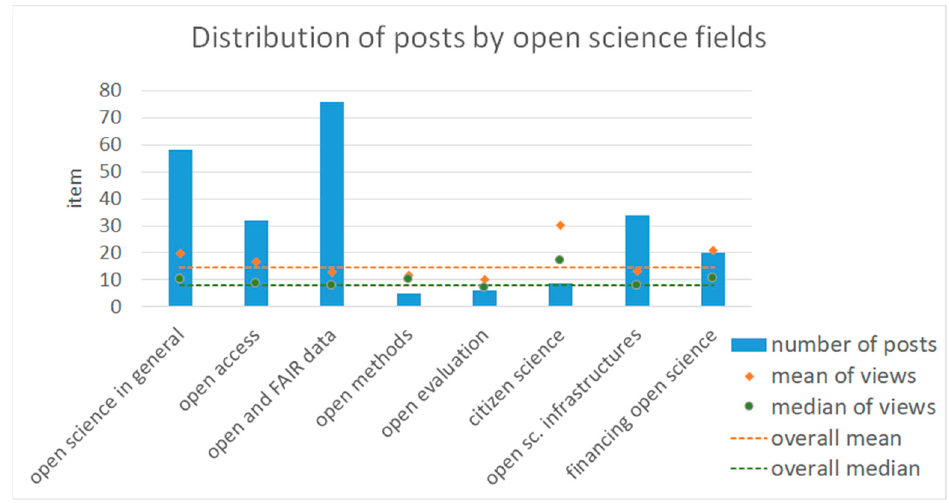
Figure 1. Distribution of posts by open science fields.